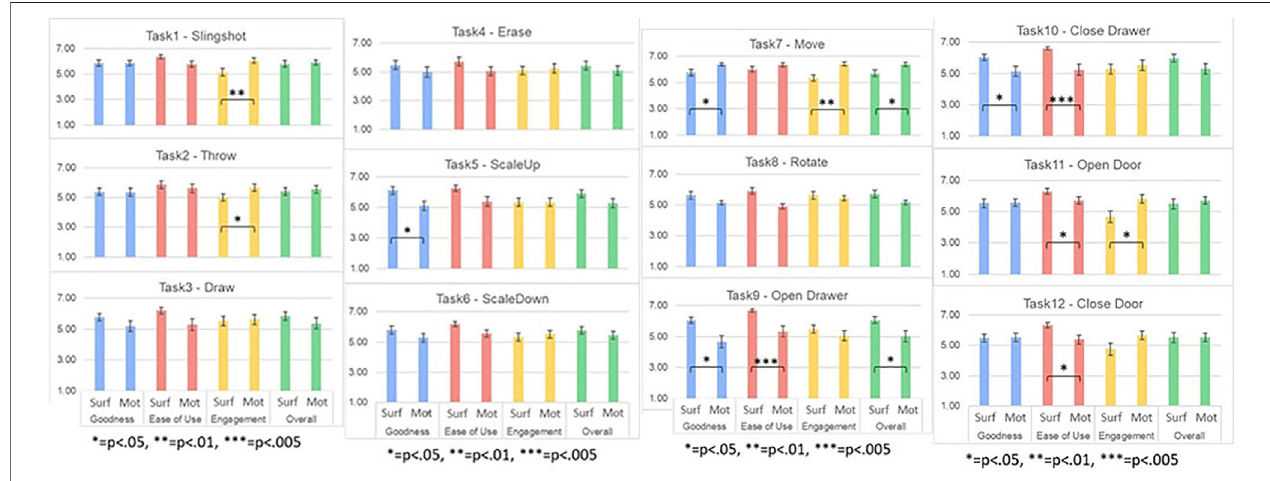
FIGURE 4 | Subjective ratings in terms of Goodness, Ease of Use, Engagement, and Overall ratings for Task 1 – 12.